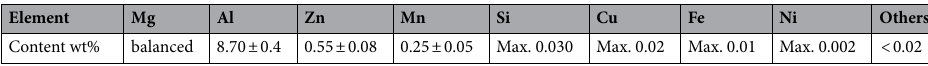
Table 1. Chemical composition of commercially available AZ91 alloy used in this